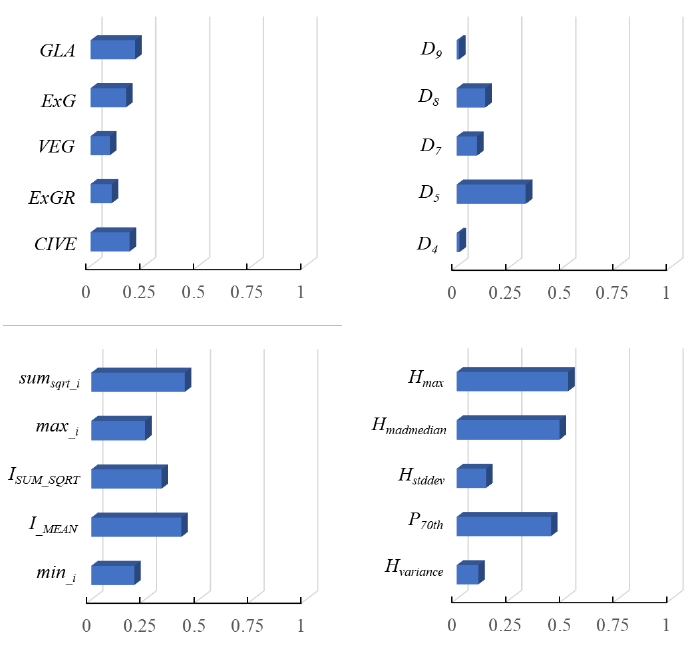
Figure 6. Variable correlations with IT-AGB (Top 20 variables).